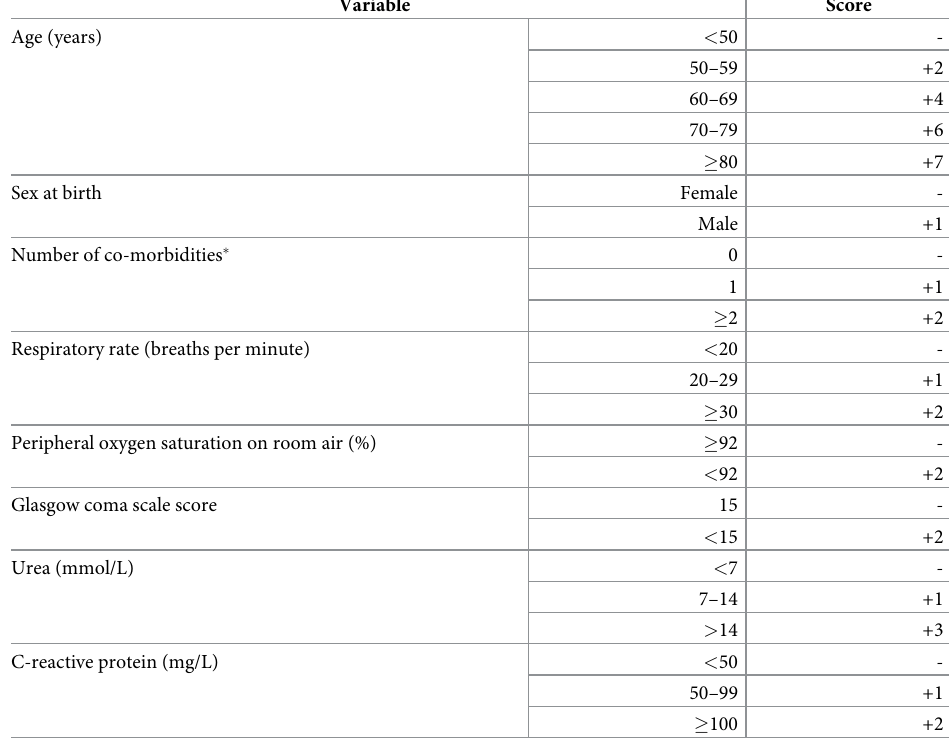
Table 1. Demographic and clinical components of the ISARIC 4C COVID-19 mortality score and associated score weights.